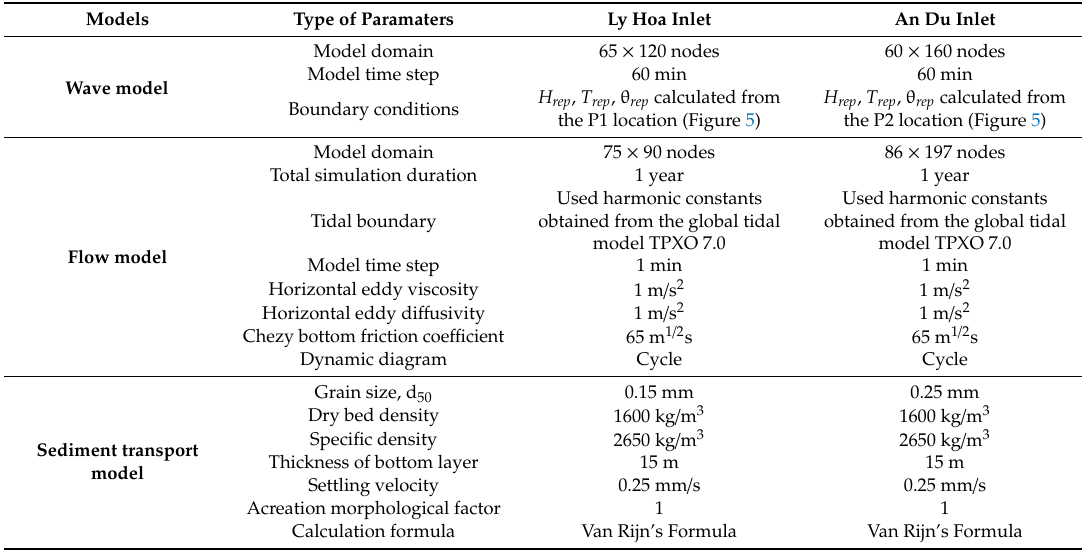
Figure 5. Delft3D model grids for ( a ) the Ly Hoa Inlet ( b ) the An Du Inlet. Table 2. Summary of the Delft3D model